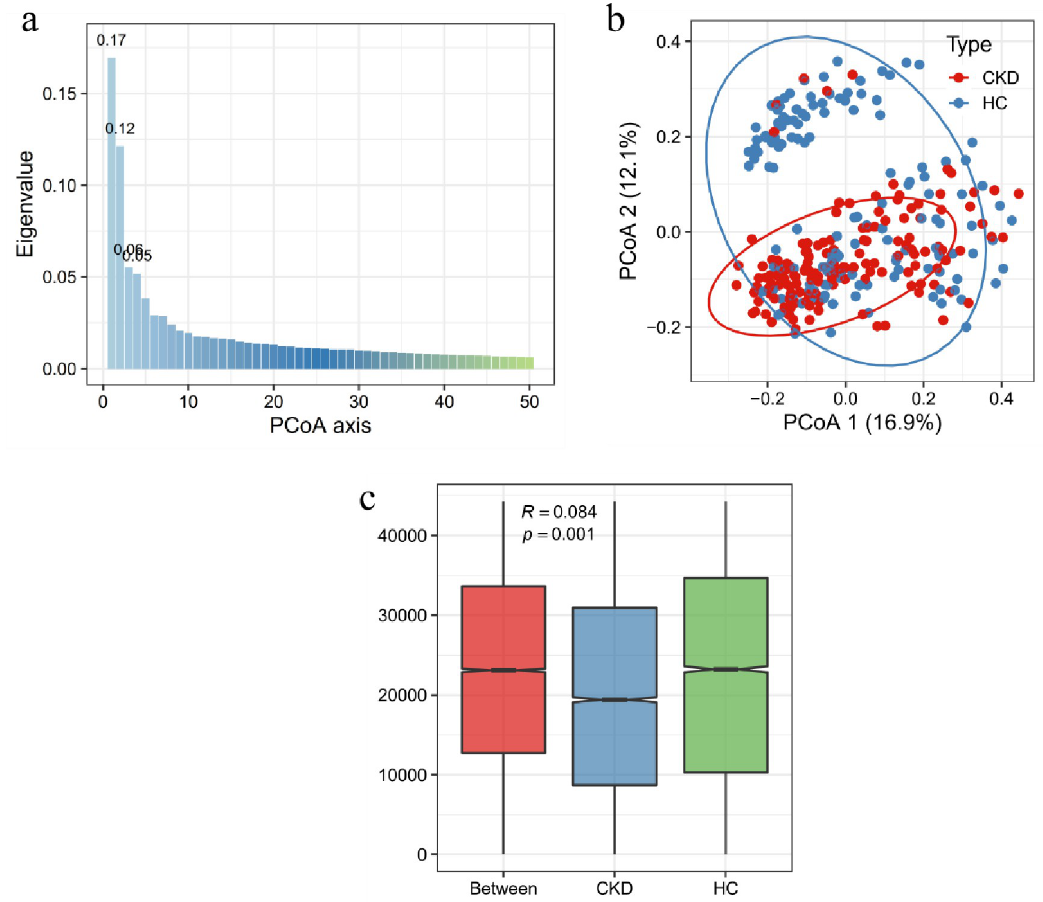
Fig 4. PCoA analysis in genus level in different groups. (a) PCoA scree plot showed the first two axes account for 29% of the total variance. (b) PCoA ordination plot of axis 1 and 2 showed the clustering of samples in different groups. (c) ANOSIM test showed the intergroup difference between CKD and HC groups (P =